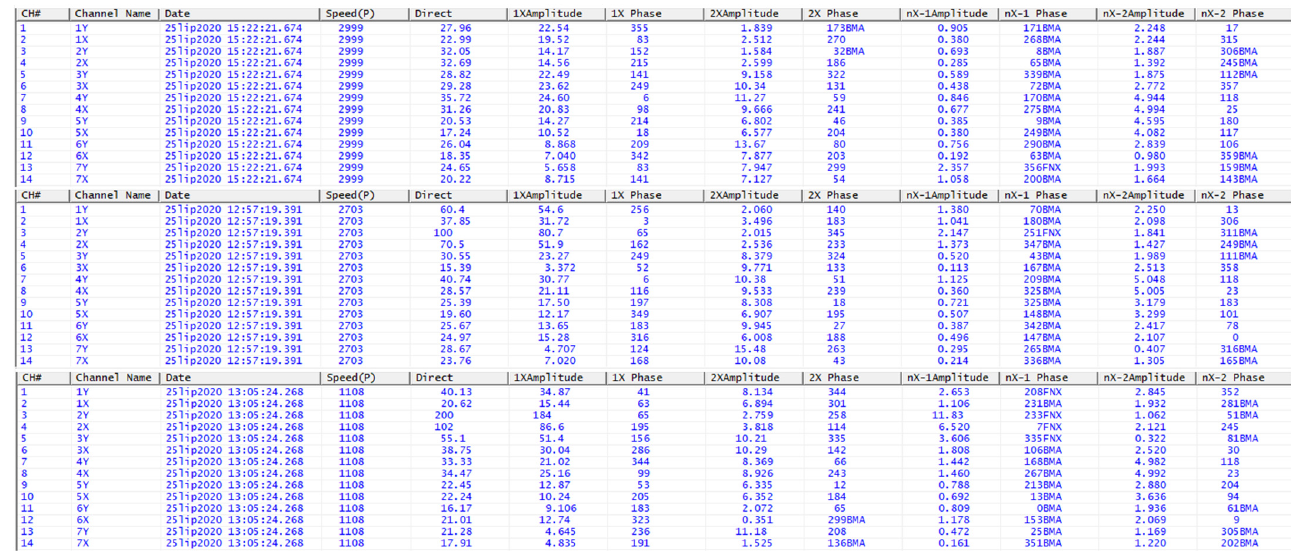
Figure 4. Data features example. The view of the features generated by the portable acquisition unit.